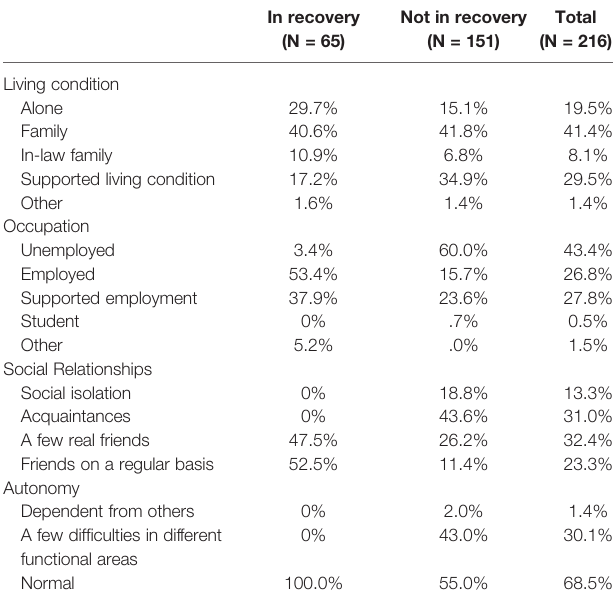
TABLE 1 | Sociodemographic variables between the two groups (percentages).